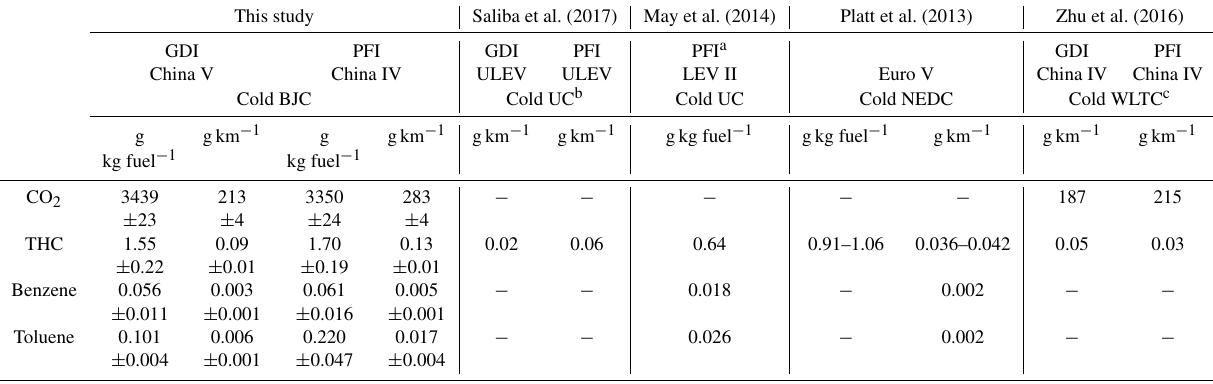
Table 3. Emission factors (EFs) of gaseous pollutants from the gasoline direct injection (GDI) and port fuel injection (PFI) vehicles in this study and those of previous studies.